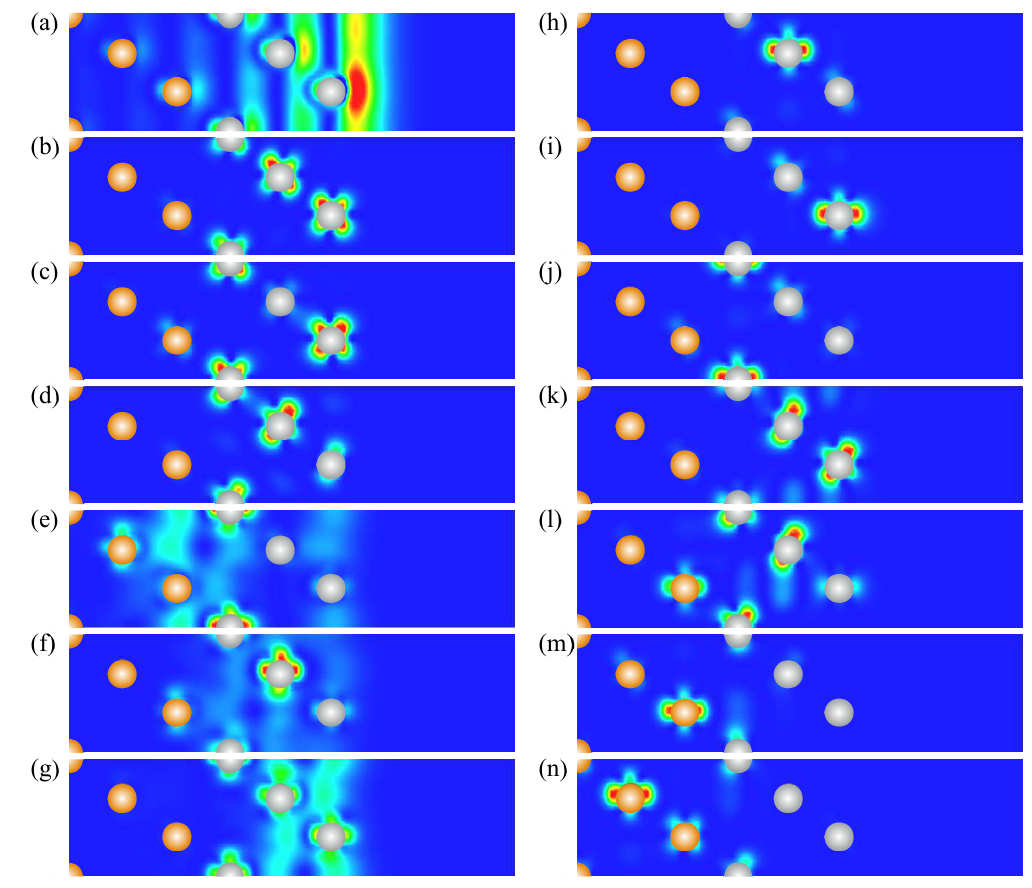
Figure 11. Charge density distribution of (a) Γ 1 , (b) Γ 2 , (c) Γ 4 , (d) Γ 6 , (e) M 7 , (f) M 8 , (g) M 9 , (h) K 10 , (i) K 11 , (j) K 12 , (k) K 13 , (l) K 14 , (m) K 15 , (n) K 16 surface, quantum-well, and interface states in the 3 ML-Pt/Au(111) heterostructure. The Pt and Au atomic positions are shown by grey and yellow dots,